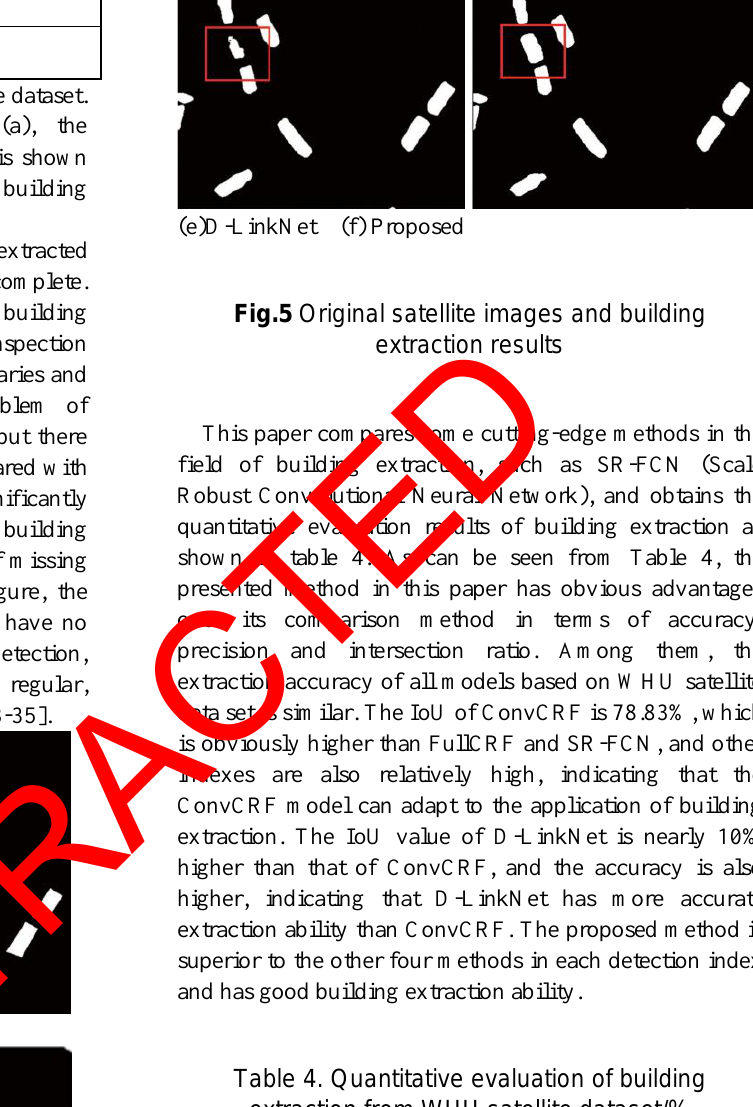
Table 4. Quantitative evaluation of